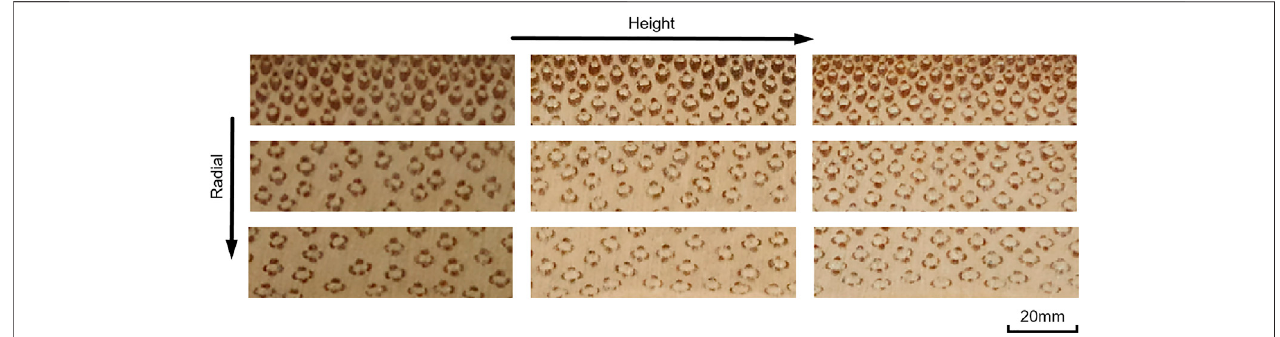
Frontiers in Materials |